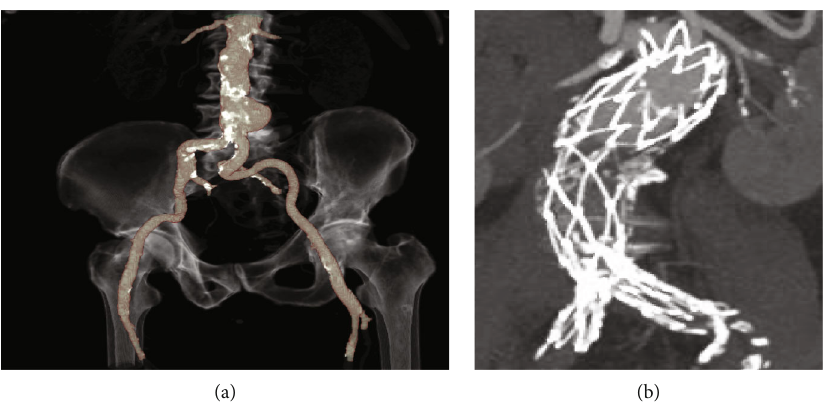
Figure 1: (a) Three-dimensional volume rendering of a penetrating aortic ulcer (PAU). The image illustrates an infrarenal PAU with a calci fi ed and narrow aortic bifurcation prior to endovascular treatment. (b) Coronal multiplanar reformation following AFX stent graft placement at 3-year follow-up. The main unibody was deployed directly onto the aortic bifurcation. The proximal aortic tube stent graft extension seals in the infrarenal segment. No endoleak (EL), stent graft migration, or limb stenosis occurred after implantation. Table 1: Patient demographics and comorbidities. Patient demographics and comorbidities are presented as mean ± standard deviation or absolute and relative frequencies ( n (%)) for abdominal aortic aneurysm (AAA) and penetrating aortic ulcer (PAU) ( n = 35 ).